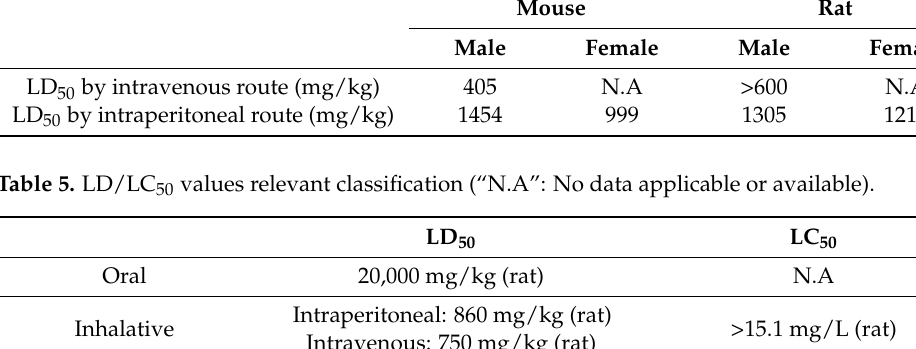
Table 4. Acute toxicity of ACV (“N.A”: No data applicable or available).